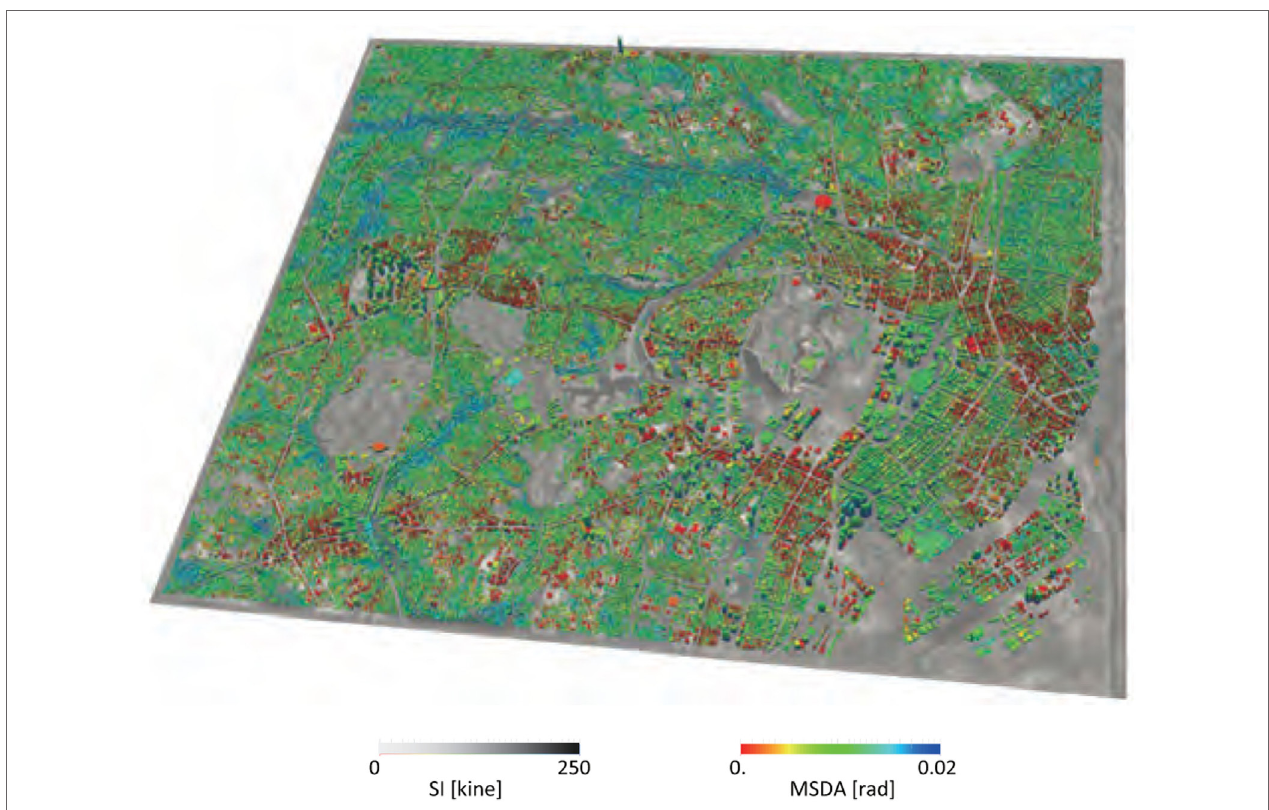
FigUre 13 | Distribution of SI and MSDA computed by making combined simulation of ground motion and seismic